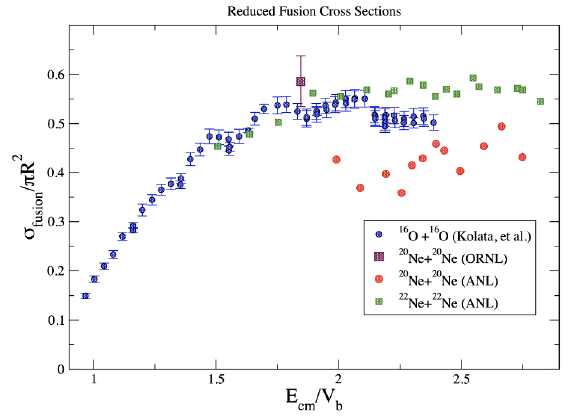
Figure 10. Reduced fusion cross sections for Ne + Ne systems. The "ANL" data are from [21] and the "ORNL" data from [22]. A comparison with 16 O + 16 O fusion [23] is also illustrated.